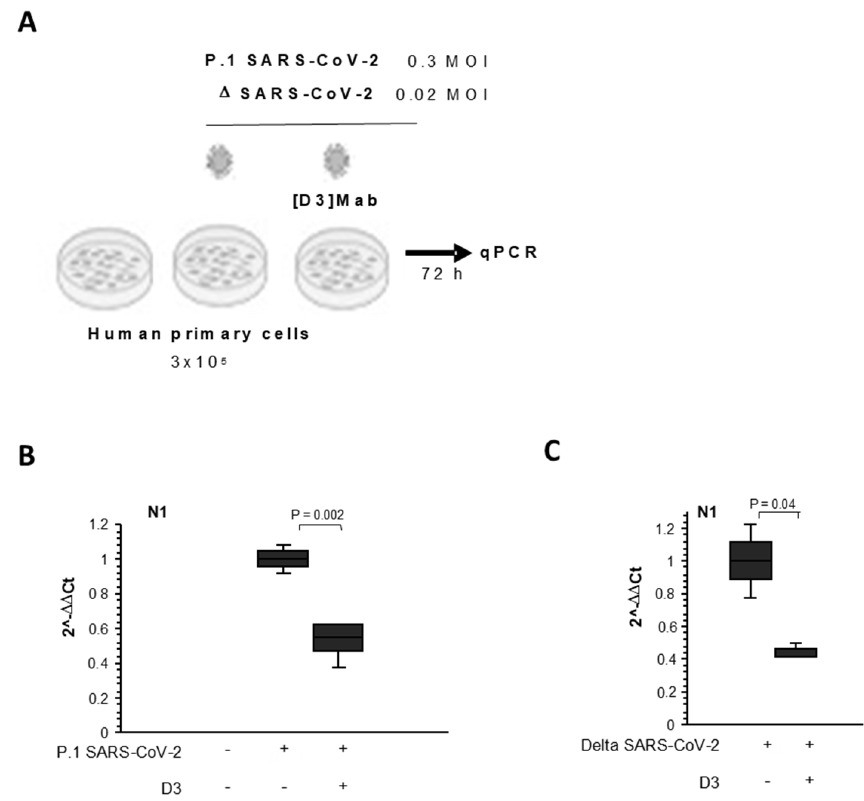
Figure 8. Effects of D3 on infectivity of Delta and Gamma variants in cell cultures. ( A ) Schematical representation of neutralization assays. Primary human epithelial cells from nasal brushing (3 × 10 5 ) were plated in a 6-well plate and infected with SARS-CoV-2 viral particles (VOC delta, 0.02 MOIor VOC gamma (i.e., P.1), 0.3 MOI) previously incubated with D3 antibody for 2 h at 37 °C. Non-infected cells were used as the negative infection control. After 72 h, the cells were lysed, and their RNA was extracted. ( B , C ) Quantification of mRNA abundance relative to that in CTR cells (2 − DDCt) of viral N gene from Real-Time PCR analysis with SYBR Green. Non-infected cells and SARS-CoV-2–infected cells treated with vehicle (CTR) were used as controls. Data are means ± SD. Statistical significance was defined as P <0.05 by unpaired two-tailed Student’s t-tests.